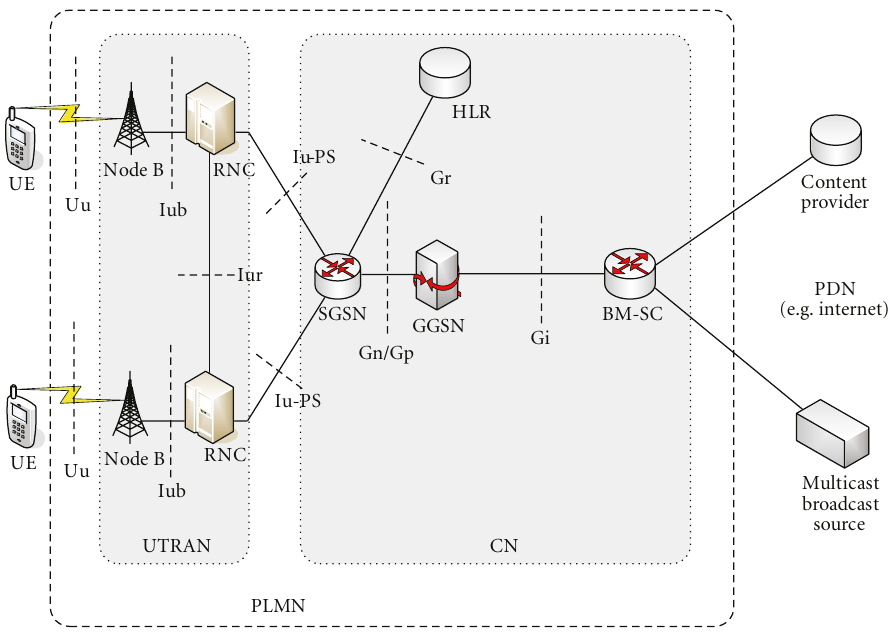
Figure 1: UMTS and MBMS